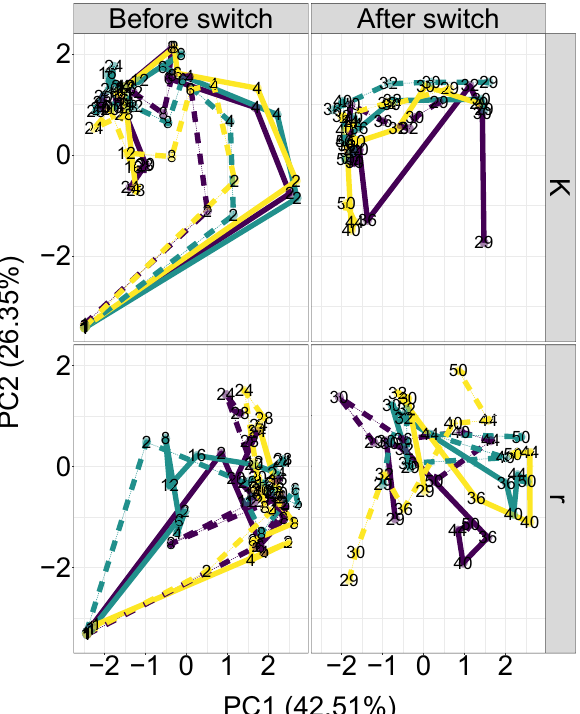
Figure 4. PCoA ordination of Bray-Curtis distances between samples showing the time trajectories for each microcosm. The single ordination was faceted vertically based on the state of selection regime at the time of sampling (being r or K -selection), and horizontally to highlight temporal trends. Solid and dotted lines indicate high (H) and low (L) resource supply, respectively. The labels indicate the day of sampling, whereas the line colours are purely to visually distinguish the replicate time